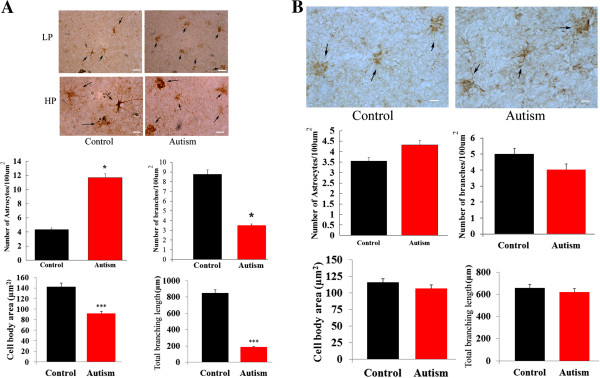
The morphology and density of astrocytes were significantly changed in the frontal cortex of autistic subjects. Immunohistochemistry studies were carried out on frontal cortex (A) and cerebellum sections (B) from six autistic subjects and six age-matched controls using an anti-glial fibrillary acidic protein (GFAP) antibody (dilution 1:1000). Pictures were taken under both low power (LP) and high power (HP). Immunostaining of GFAP (dark brown color) was present in all astrocytes. The density of astrocytes, number of astrocytic branch processes, cell body size and the total branch length were quantified using Image J analysis. *P < 0.05, ***P < 0.001. Scale bar: 20 μm. Data are shown as mean ± standard error (SE).